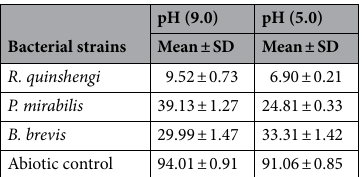
Bacterial strains